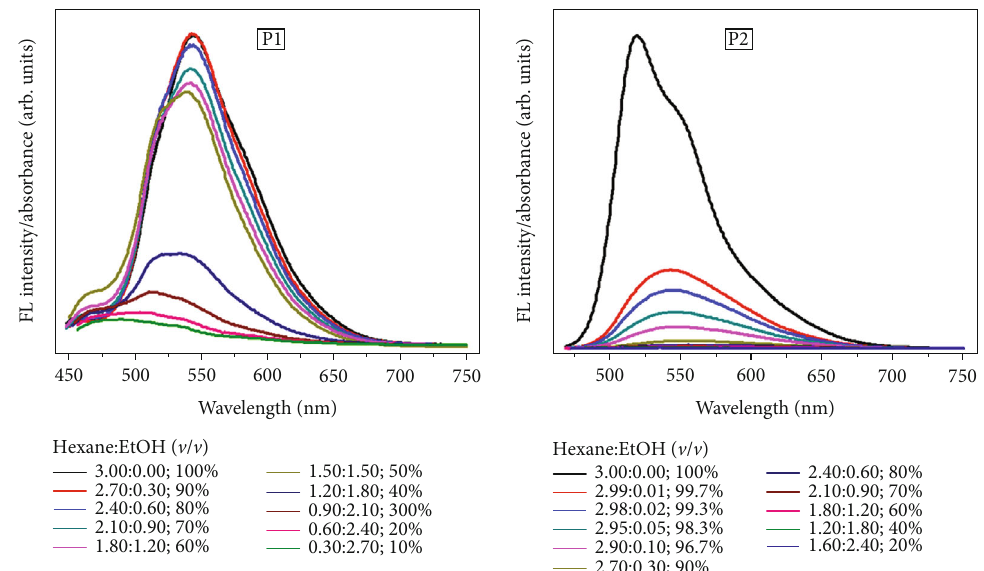
Figure 11: Absorbance-corrected fl uorescence emission (excited at the corresponding absorption maximum) spectra of P1 and P2 as dilute solutions in mixed hexane/EtOH solvent of di ff erent volume ratios. Note that P2 has poor solubility in hexane, and the upper, clear portion of a saturated P2 solution in hexane was collected and used as the stock solution.